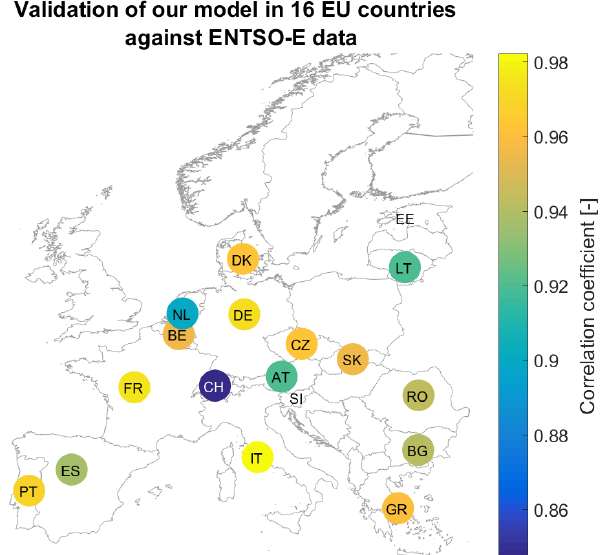
Figure 12. scatter plot of the correlation coefficients between model output and ENTSO-E data against installed PV capacity for the 16 different